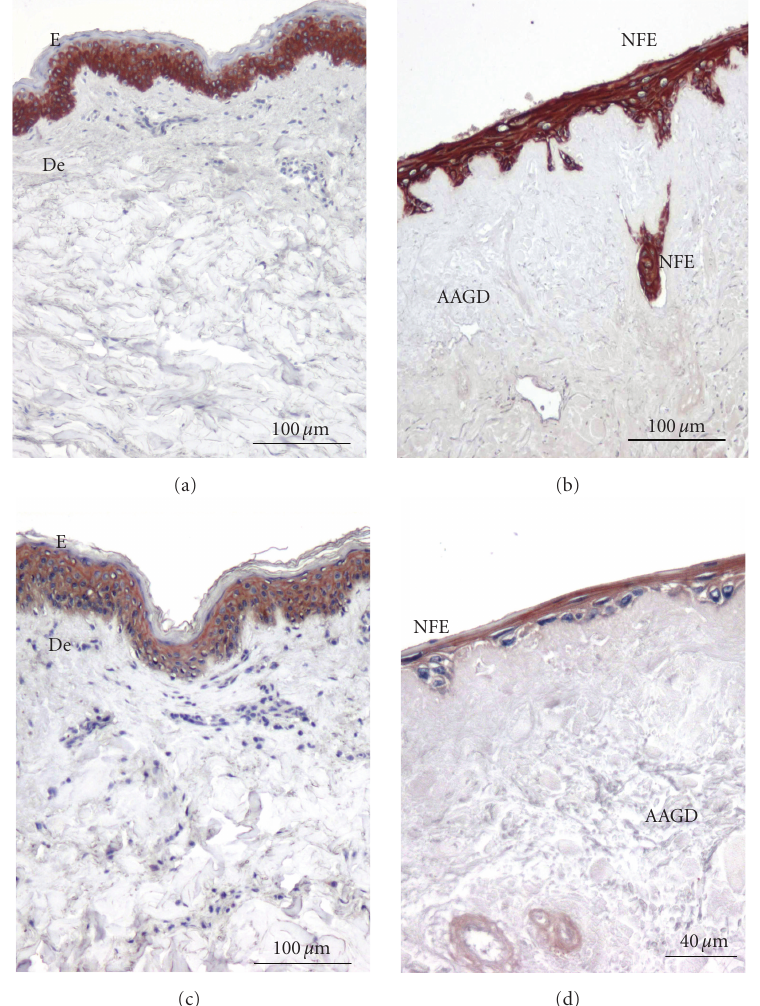
Figure 9: Immunohistochemical localization of human keratin in NS ((a) and (c)) and biosubstitute ((b) and (d)) at 14 days. ((a) and (b)) : The sections were stained with cytokeratin 14 Moab and ((c) and (d)) E-Cadherin Moab. Original magnification: 10x ((a), (b), and (c)) 20x (d). E: epidermis, De: dermis, AAGD: alloplastic acellular glycerolized dermis, NFE: newly formed